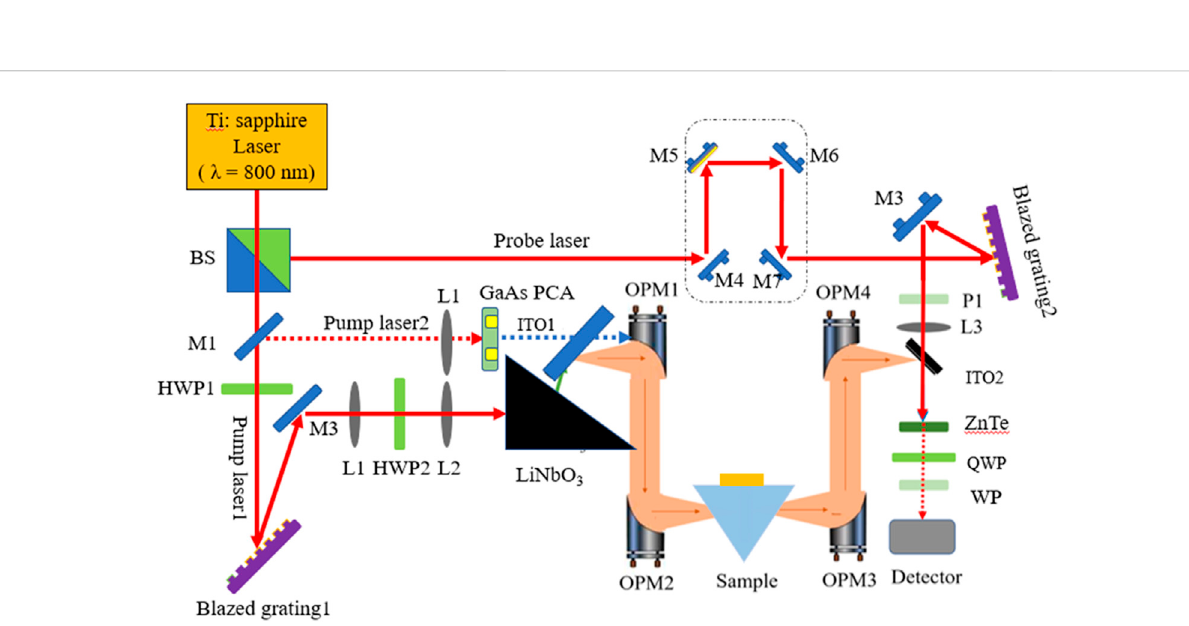
The schematic diagram of the designed optical path of the THz- ATR spectrometer for liquid biological samples is presented in Figure 2. The system mainly comprises a MaiTai femtosecond laser, THz radiation sources (LT-GaAs PCA and LiNbO3 crystal), ATR prism, and THz detector. The MaiTai XF- 1 titanium sapphire femtosecond laser oscillator from Spectra- Physics is used as the seed light source, with an average output power of approximately 4.5 W. The femtosecond laser is split into pump light 1 and probe light by a beam splitter, with corresponding pulse energies of 3 W and 100 mW, respectively. Pump 1 is attenuated and then passed through mirror M1 (foldback mirror)